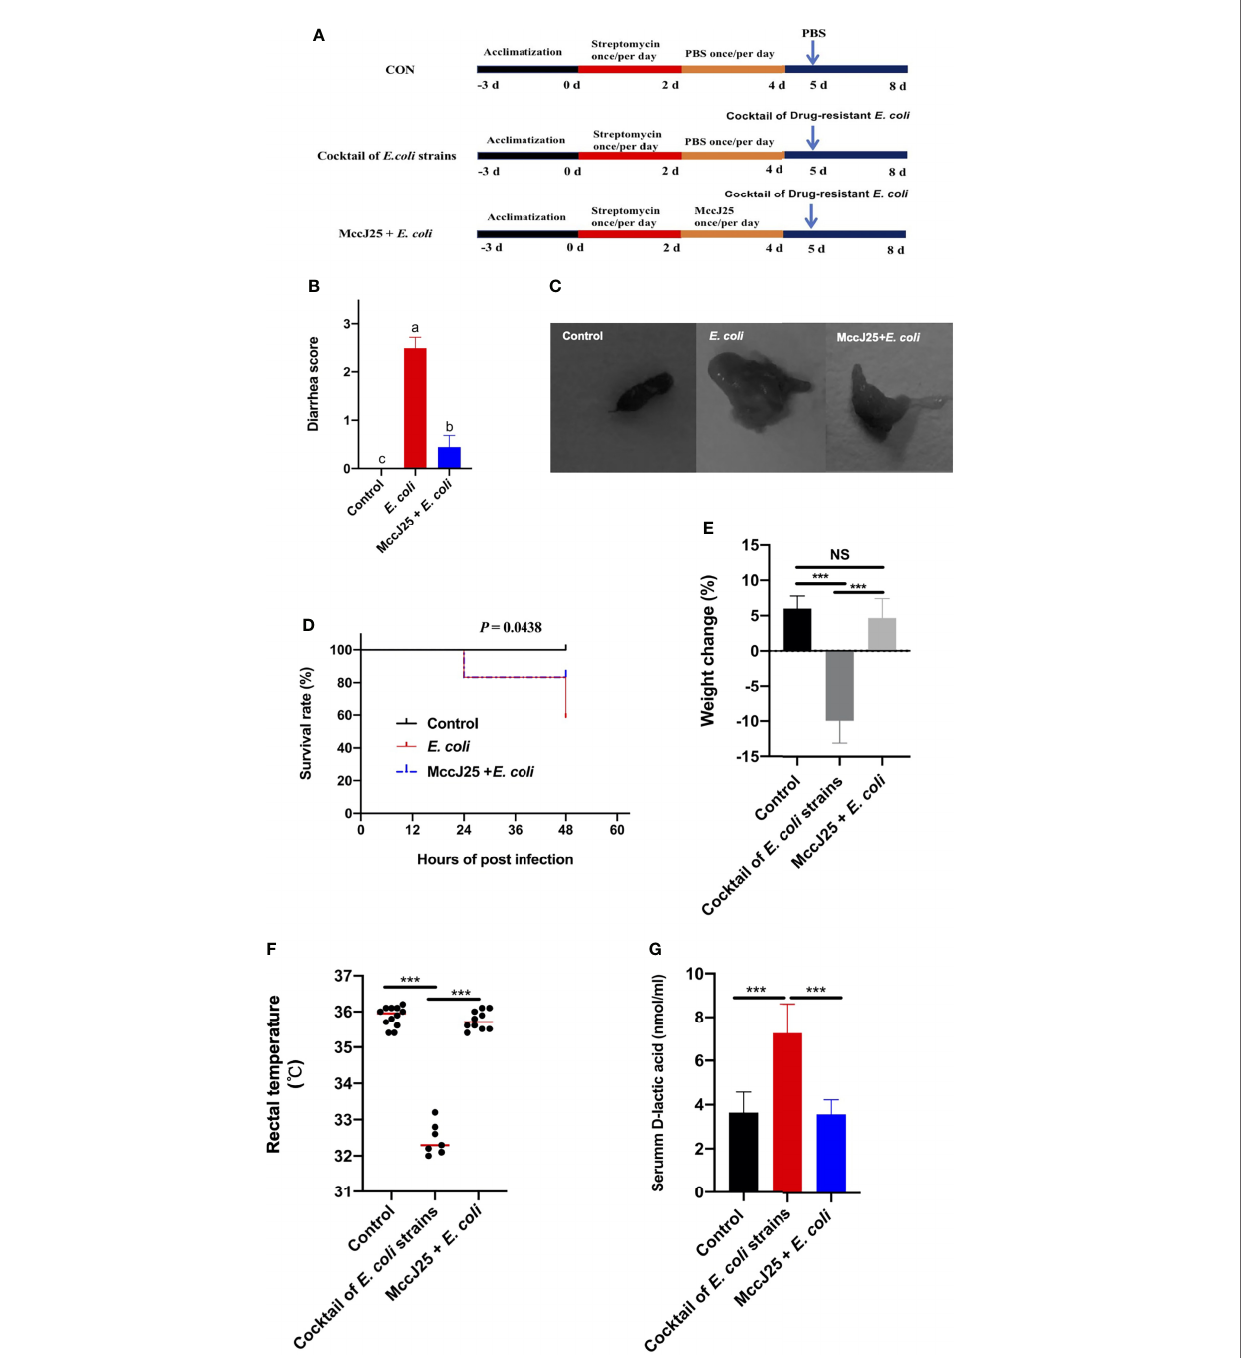
FIGURE 10 | Effects of pretreated with MccJ25 on clinical symptoms and intestinal permeability. Infected mice in the MccJ25 group received 200 m L MccJ25 once/ day for 3 d by oral gavage. Mice in the control and infected group were orally administrated with 200 m L sterile PBS. Equal volume PBS containing 10 8 CFU/mL clinically source cocktail of MDR E coli strains was challenged to infect the mice. (A) Scheme of the animal trails. (B) Evaluation of diarrhea scores (n=12/treatment group). (C) Representative image of feces. (D) Percentage of survival and body weight changes (E) of experimental mice (n = 12/treatment) up to d 3 after cocktail of MDR E coli strains infection. (F) Record of rectal temperature after cocktail of MDR E coli strains infection (n = 12, 7, 10, respectively). (G) Serum D-lactic acid concentrations after cocktail of MDR E. coli strains infection (n = 6). Results are indicated as the mean ± standard error of mean. Signi fi cant differences were determined using a one-way ANOVA followed by a Tukey ’ s multiple range test. Statistical difference test of survival curves was analyzed by the Mantel-Cox (log rank). Different superscript lowercase letters within each group indicate signi fi cant differences ( P < 0.05). NS, P > 0.5, *** P <